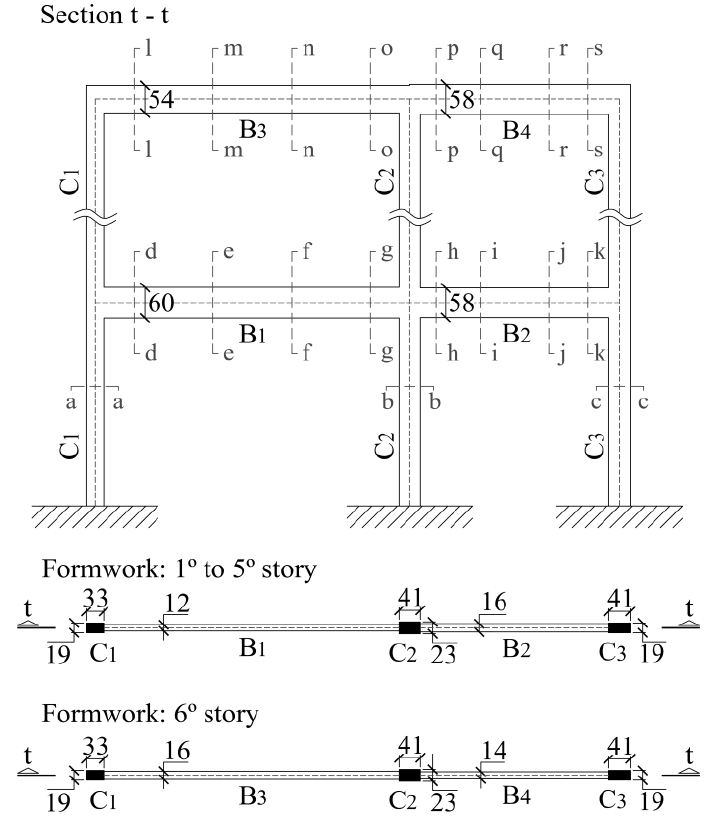
Figure 11. Optimal structure (dimensions in cm) - Example II: case